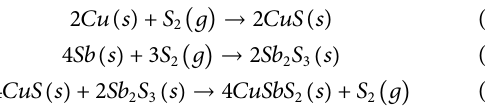
Frontiers in Materials |